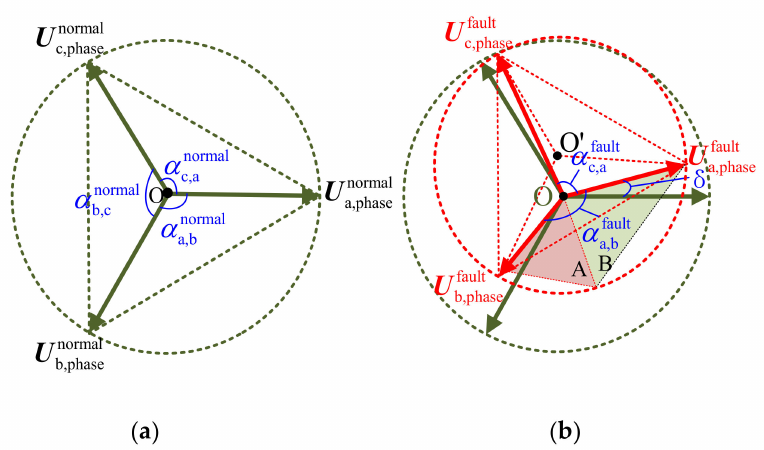
Figure 3. The vector diagram of output phase voltages. ( a ) Normal operation; ( b ) Fault-tolerant